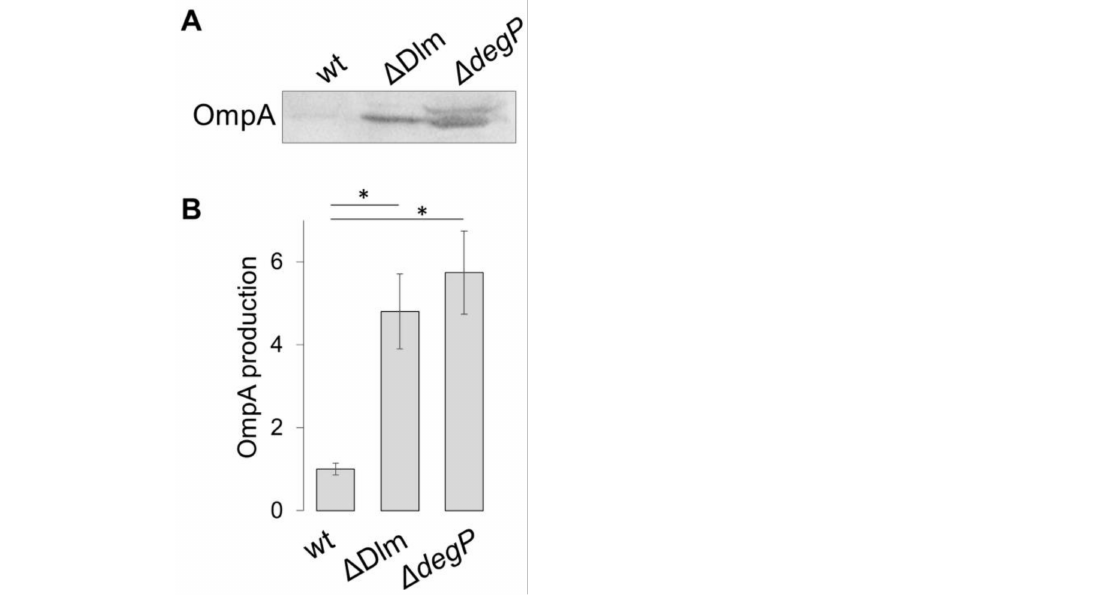
Figure 2. Comparative analysis of OMV production in ∆ Dlm and ∆ degP background. ( A ) Western blot analysis of OmpA in OMVs isolated from ULS153 (wt), ULS153 ∆ Dlm and ULS153 ∆ degP . Blots of SDS-PAGE separations were probed with anti- E. coli OmpA antibody. ( B ) Relative OmpA abundance determined by densitometry. The OmpA bands of the ∆ Dlm and ∆ degP strains were normalized to that of the wt. Vertical bars indicate the standard deviation of three independent experiments. Statistical significance was determined by the t test, and p values are as follows: * p <